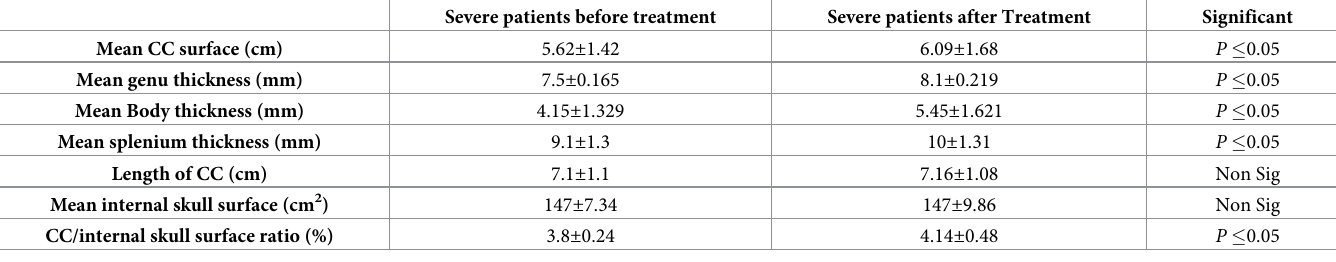
Table 5. Average CC values in severe Alzheimer disease individuals: Before and after